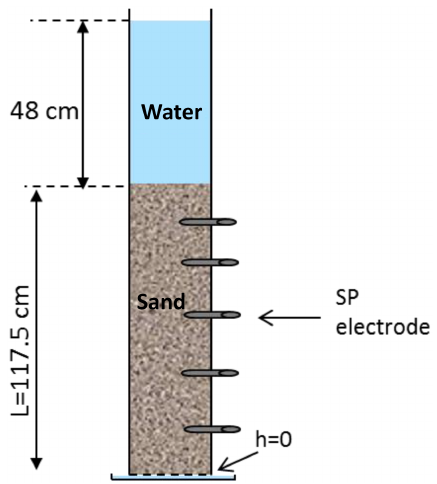
Figure 1. Illustration of the experimental